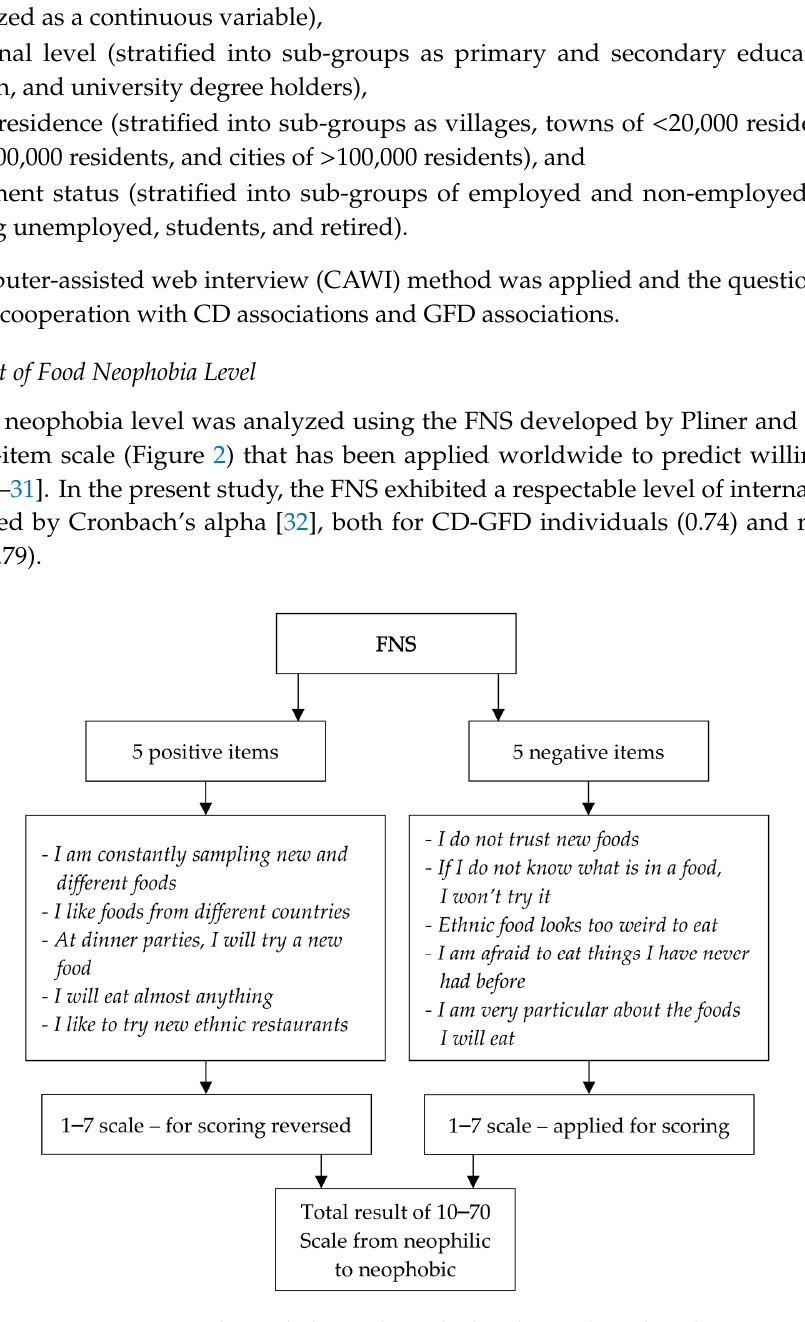
Figure 2. Food Neophobia Scale applied in the conducted study.